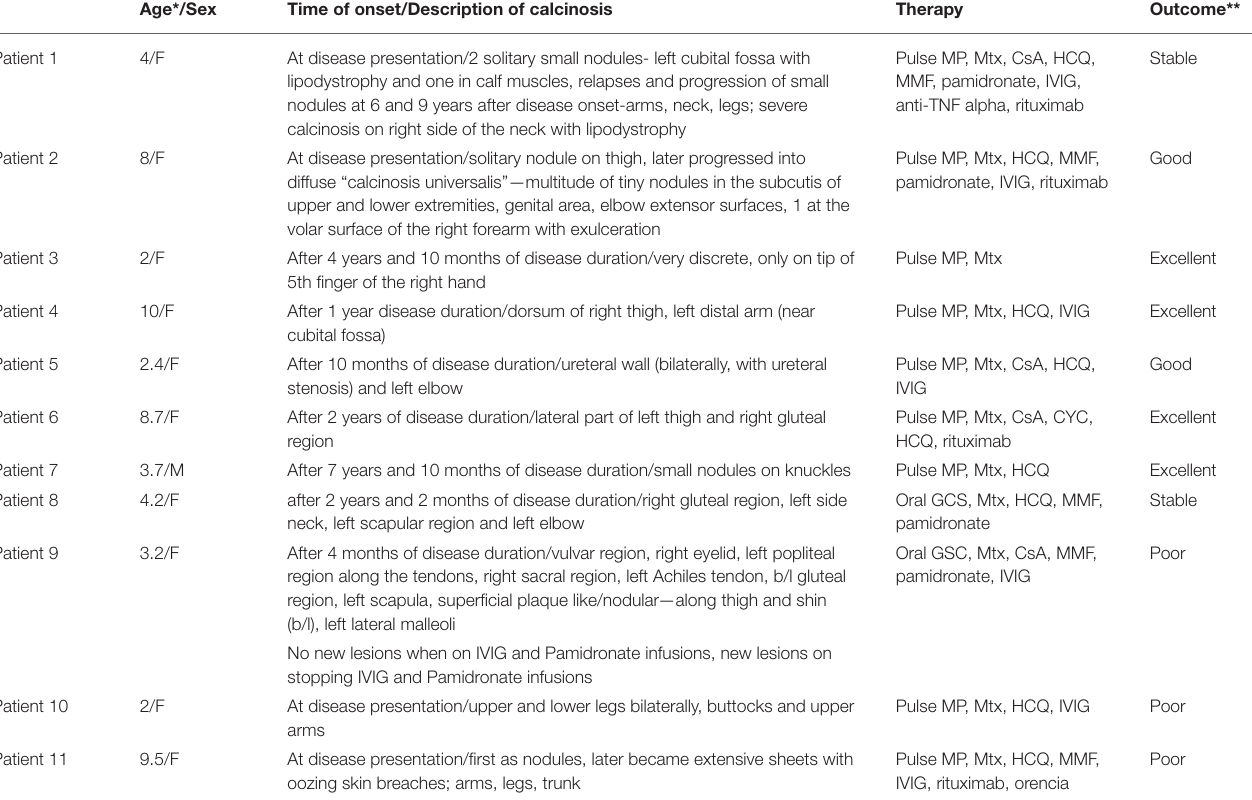
TABLE 3 | Clinical characteristics of calcinosis, treatment and outcome of patients with calcinosis. Age*/Sex Time of onset/Description of